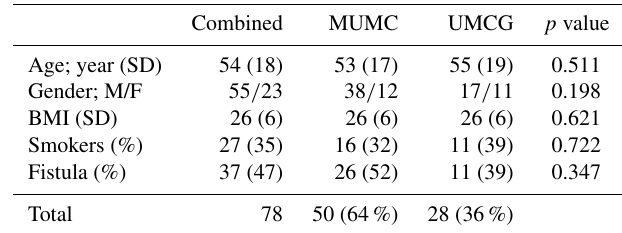
Table 1. Baseline patient demographics.